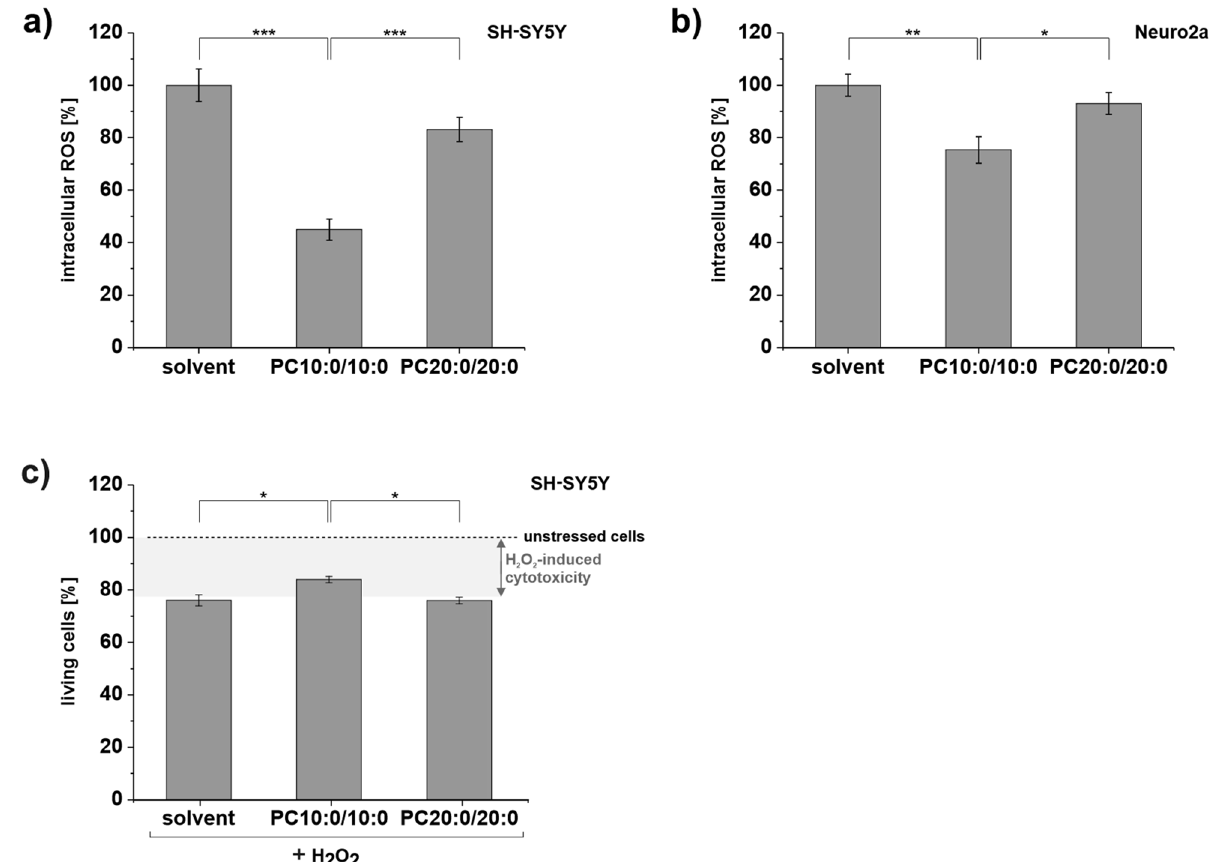
Figure 2. Impact of PC10:0/10:0, PC20:0/20:0 or solvent on the intracellular ROS level and H 2 O 2 -induced cytotoxicity. Cells were incubated with the solvent EtOH (0.2%) (set as 100%), PC10:0/10:0 or PC20:0/20:0 (10 µM) in absence (a,b) or presence (c) of 500 µM H 2 O 2 for 18 h before intracellular ROS level and H 2 O 2 - induced changes in cell viability were examined. Intracellular ROS level measured by using CellROX Green in ( a) SH-SY5Y cells (n = 13) and ( b) Neuro2a cells (n = 12). ( c) H 2 O 2 -induced changes in the viability of SH-SY5Y cells determined by labeling dead cells with propidiumiodide (n = 4) . Error bars represent SEM. Asterisks